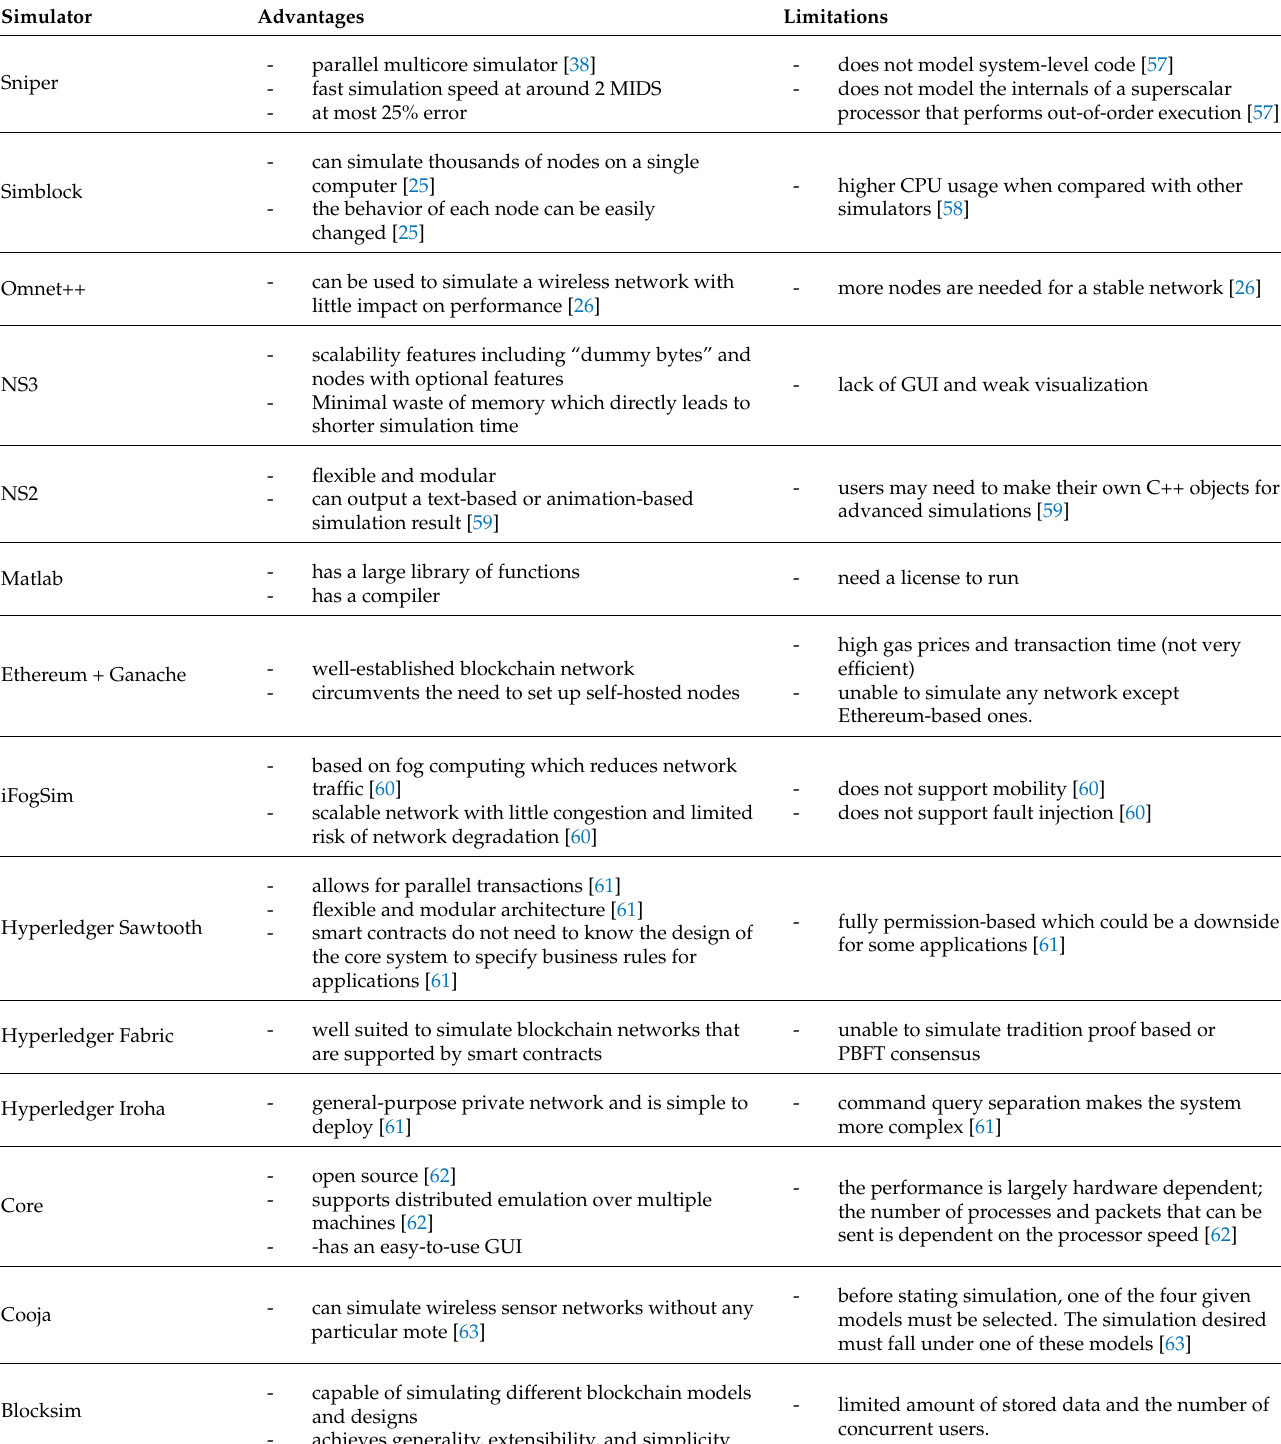
Table 6. Advantages and limitations of blockchain simulators for IoT